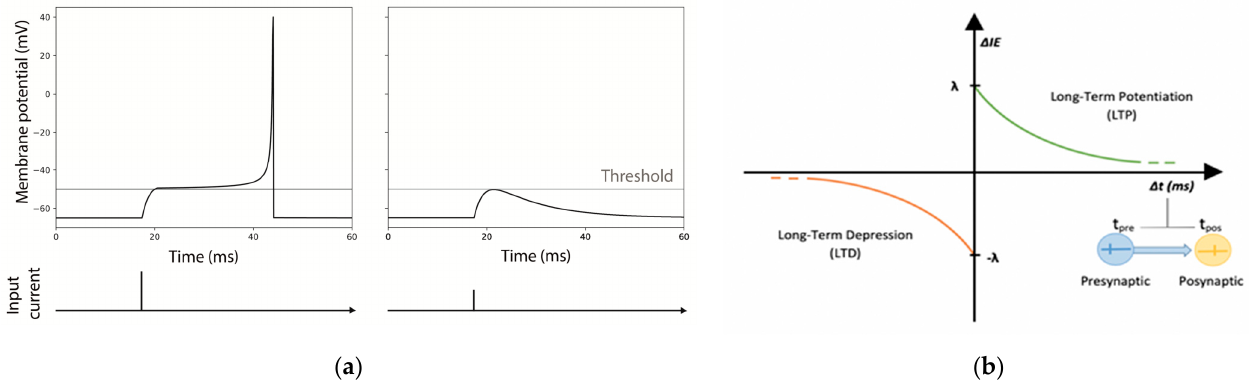
Figure 2. Behavior of the LIFL-IE module: ( a ) internal computation of LIFL-IE under an impulsive excitatory injected current. The first input is sufficiently strong to lead the V m,NEST over-threshold and generate an action potential, while the second input is too weak to lead the V m,NEST over the threshold. The vertical line represents the stimulus onset, whereas the horizontal one represents V m ; ( b ) scheme of intrinsic excitability plasticity, showing IE-LTP and IE-LTD. Δ t is the time difference between presynaptic postsynaptic spikes.